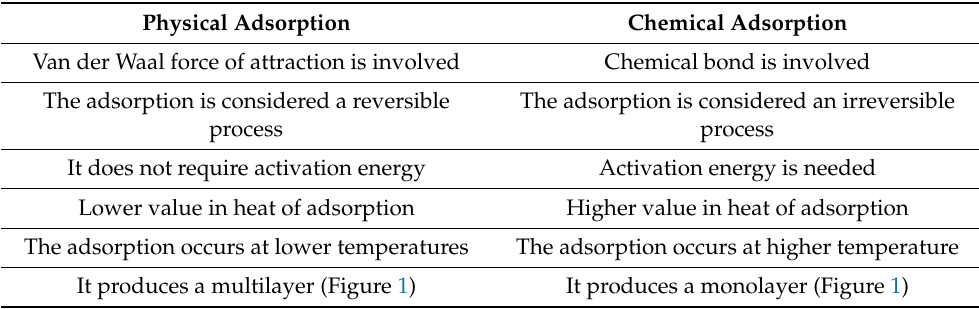
Figure 2. Physical adsorption ( a ) and chemical adsorption ( b ) [11]. Table 1. Difference between physical adsorption and chemical